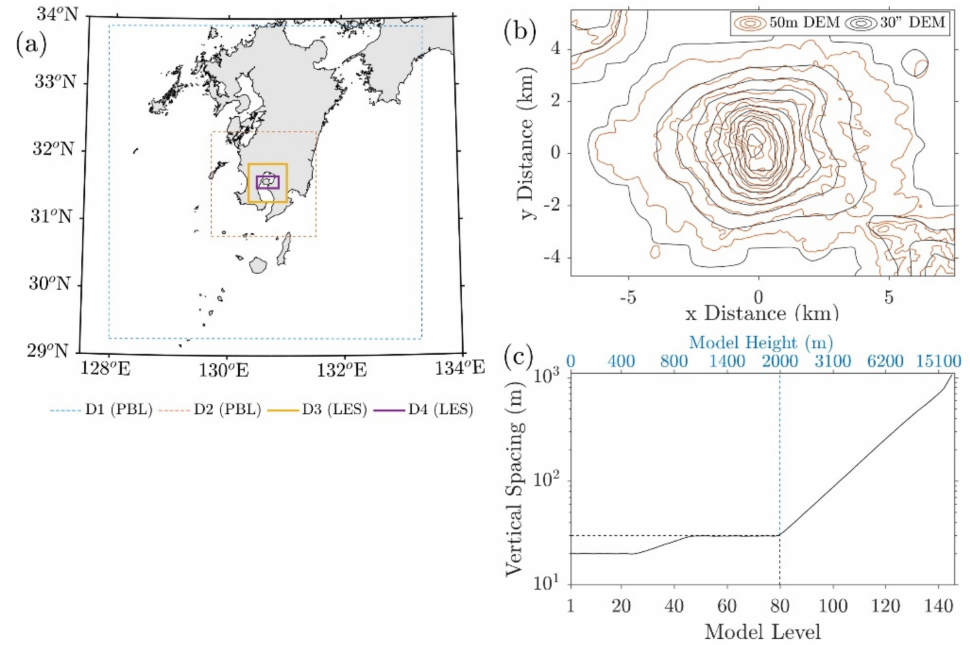
Figure 6. ( a ) Placement of the Weather Research and Forecasting (WRF) planetary boundary layer (PBL) (D1,2) and large–eddy simulation (LES) (D3,4) domains. ( b ) Topographic height as resolved in D4 using the Geospatial Information Authority of Japan (GSI) 50 m digital elevation model (DEM), shown in orange contours, and using the default WRF 30” DEM (gray contours). ( c ) Vertical spacing (left–hand y–axis) and model height (upper x–axis) against model level. Note that a logarithmic scale is used in the y–axis for Panel c